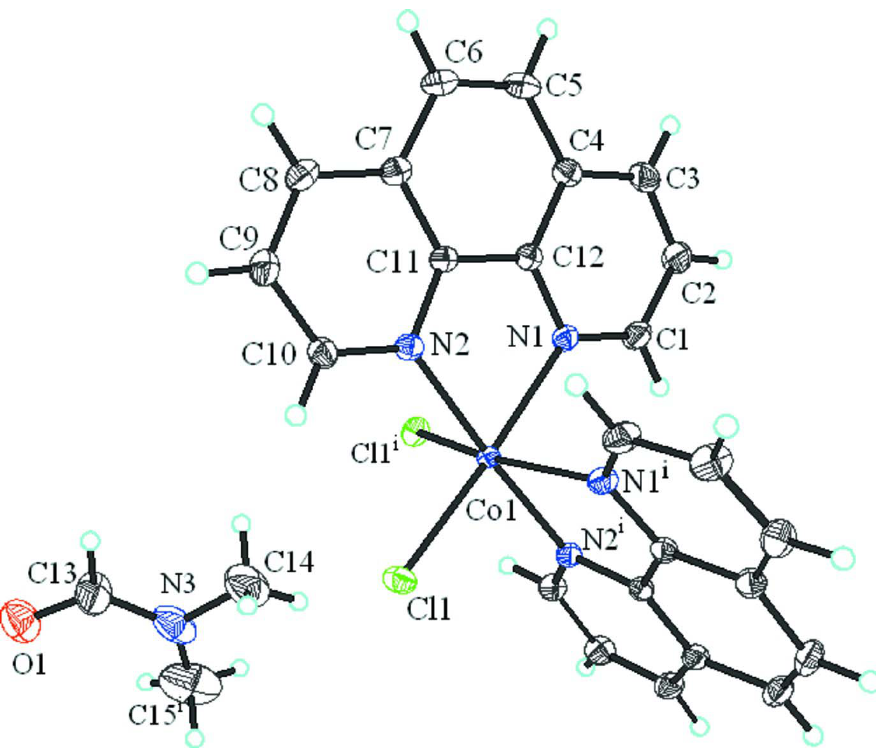
Figure 1 The structure of the title compound showing the atom numbering. Thermal ellipsoids are drawn at the 30% probability level and H atoms are shown as small spheres of arbitrary radii. Only one of the disorder components of the dmf molecule is shown. [Symmetry codes: (i) 1 - x + 1, y , 1/2 - z